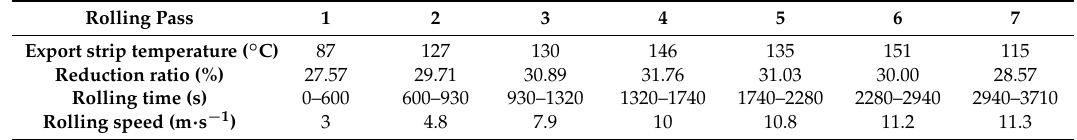
Table 1. Rolling